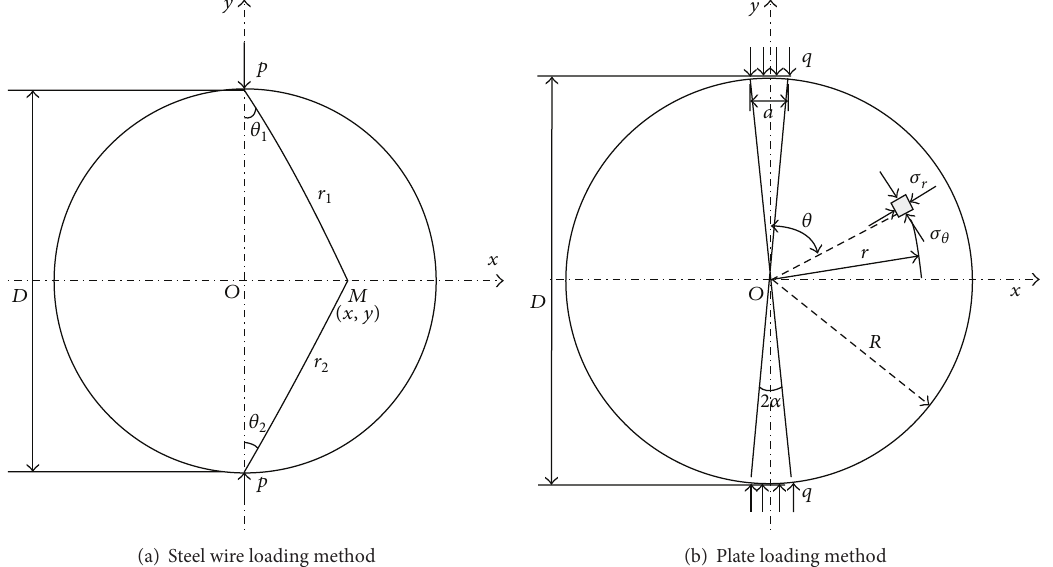
Figure 3: Curve of the wire split tests.